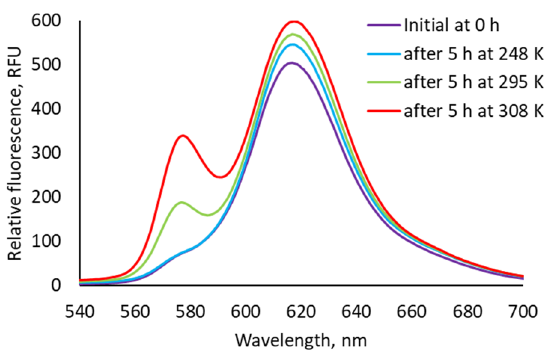
Figure 7. Emission spectra (excited at 397 nm) of bis–ZnOEP (3 × 10 − 6 M) samples with 2000 equiv- alents of cycHC[8] measured at 295 K immediately after preparation and then again after being kept for 5 h at different temperatures.